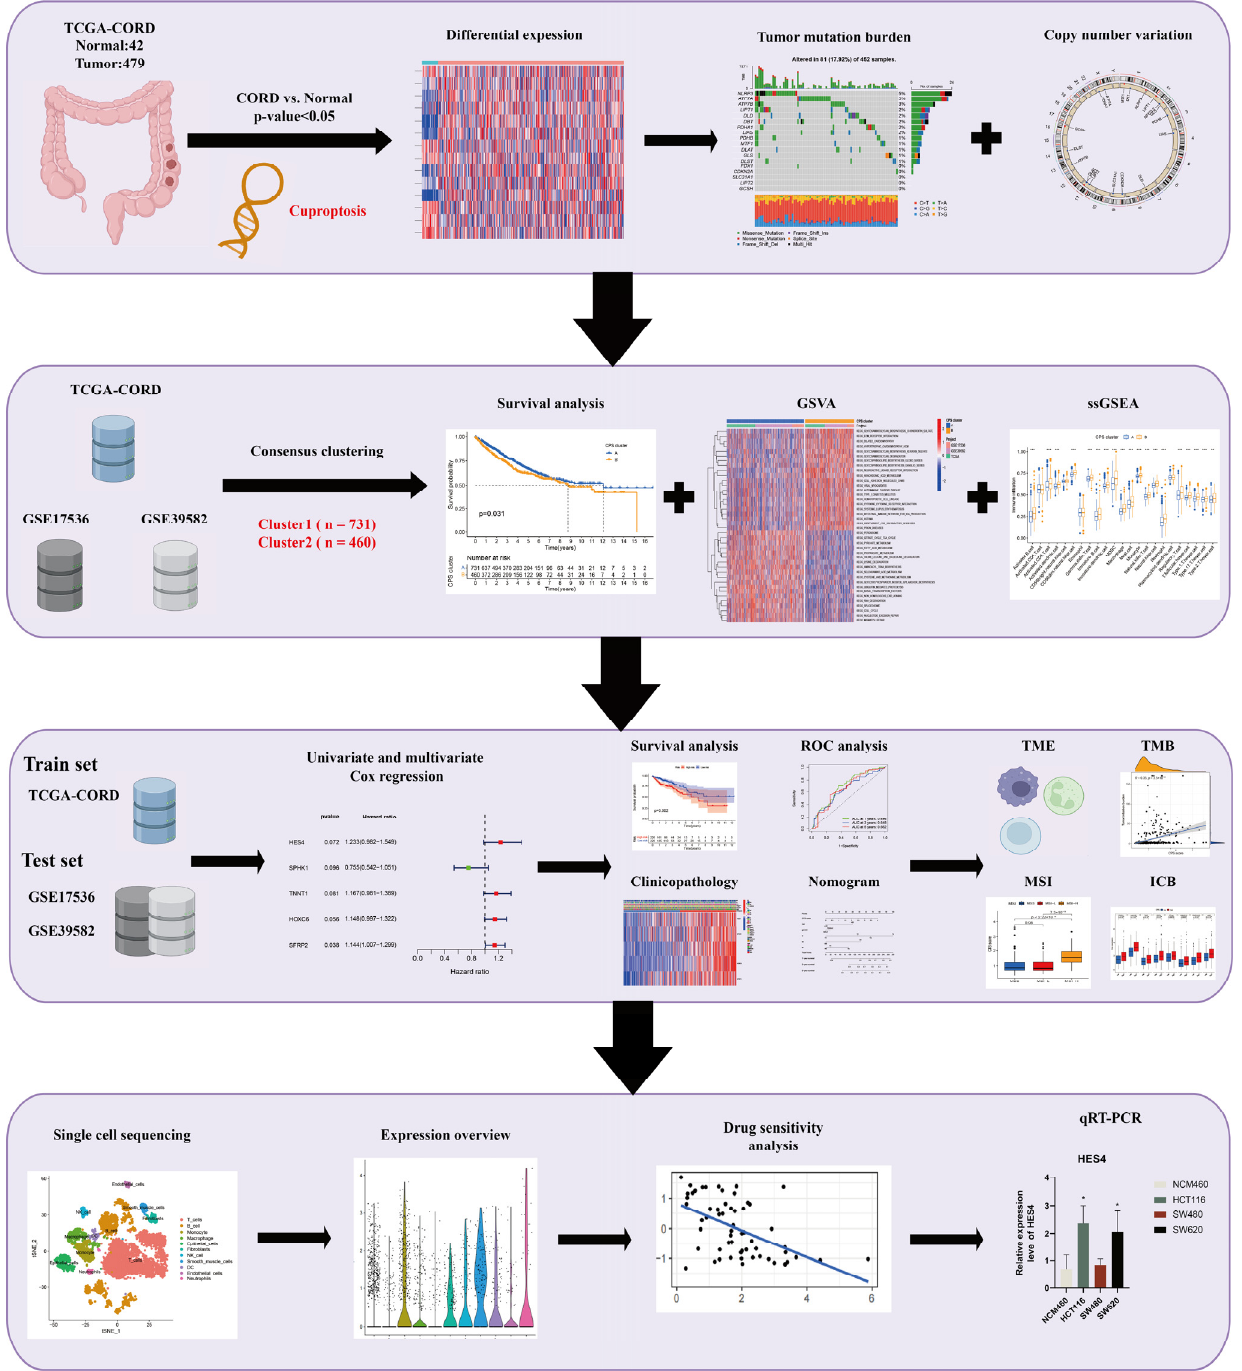
Figure 1. Flow chart of this study. * p < 0.05; ** p < 0.01; *** p < 0.001.